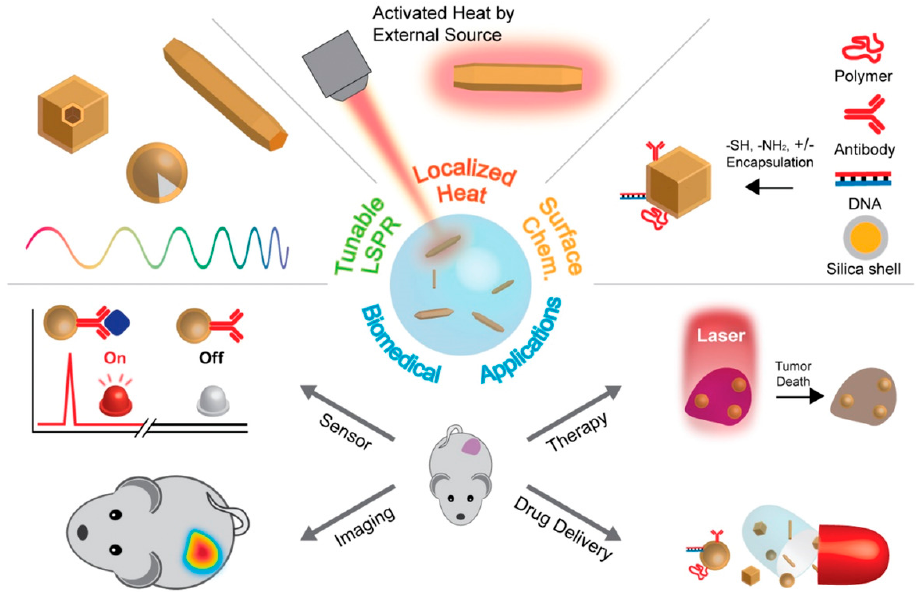
Figure 4. Biomedical applications of magnetic nanoparticles—schematic presentation [18]. (Adopted from Adv . Sci. 2019 , 6 , 1900471; open access article under the terms of the Creative Commons Attribution License, which permits use, distribution, and reproduction in any medium.)